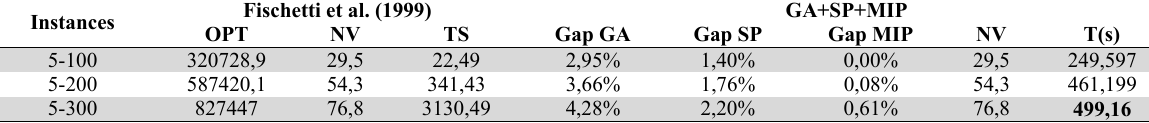
Aggregate results for the benchmark instances with 5 depots